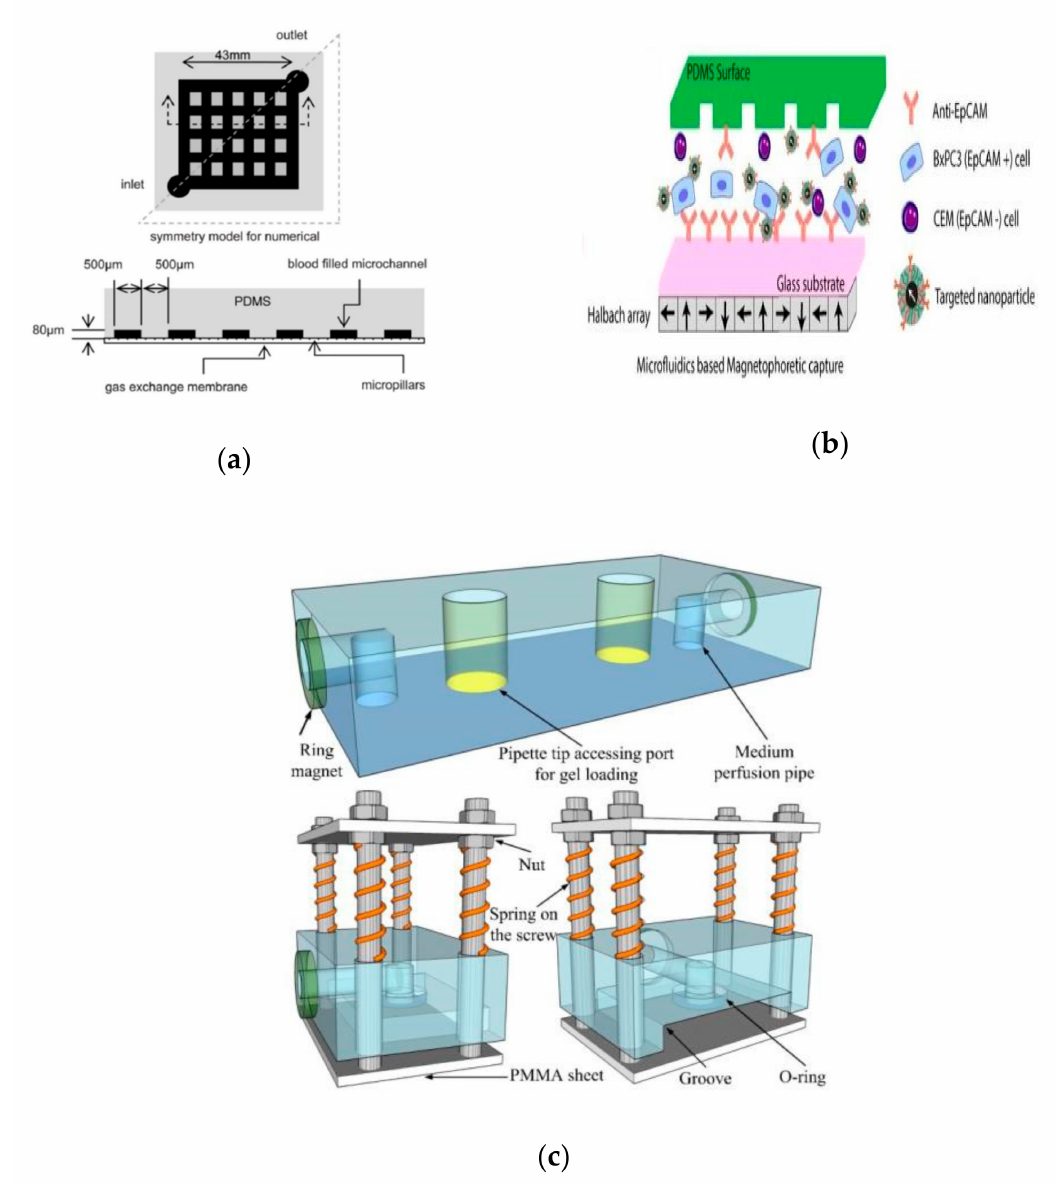
Figure 6. Several application examples of respiratory system based on lung-on-a-chip: ( a ) the microfluidic device for auxil- iary gas exchange produced by Sun et al.; ( b ) the microfluidic capture device integrated with magnetic nanoparticles; ( c ) the reusable standardized universal interface module produced by Sun et al. Reproduced with permission from